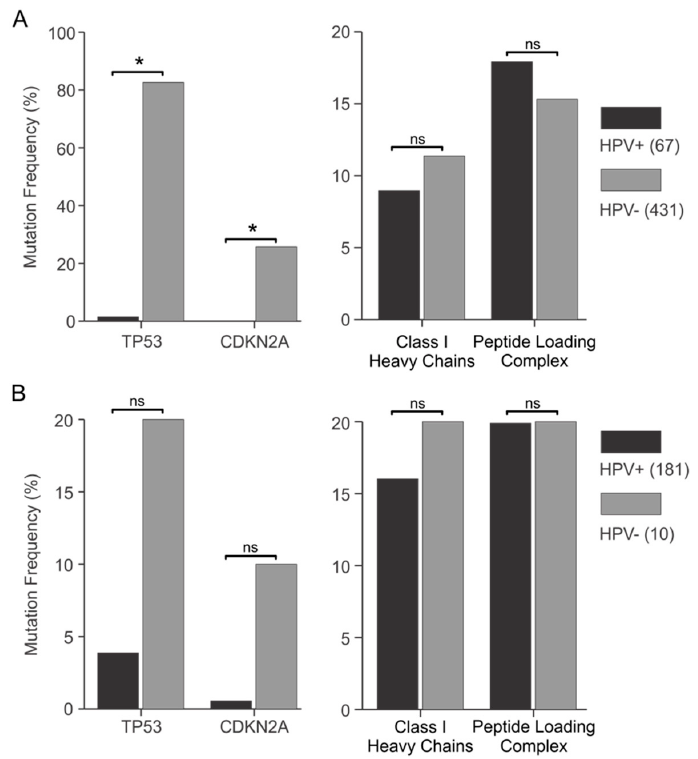
Figure 7. Comparison of the somatic mutation frequency in genes involved in MHC-I dependent antigen presentation in head & neck and cervical carcinomas stratified by HPV status. The presence or absence of somatic mutations in selected genes of the tumor samples in the TCGA HNSC and CESC cohorts was obtained from the Broad Genome Data Analysis Center’s Firehose server. The frequency of mutations in individual genes or groups of genes in HPV+ versus HPV − samples was calculated to determine whether they were influenced by HPV status. Analysis of TP53 and CDKN2A (left panels) revealed a significantly reduced frequency of somatic mutations in HPV+ versus HPV − samples in both the TCGA HNSC ( A ) and CESC ( B ) cohorts. No significant decrease was observed for somatic mutation frequency in the MHC-I heavy chain genes, or a collective grouping of all genes involved in MHC-I dependent antigen presentation between HPV+ and HPV − samples in either the TCGA HNSC ( A ) or CESC ( B ) cohorts. Numbers in brackets refer to the number of samples included in each analysis. * p ≤ 0.05; ns—not significant.